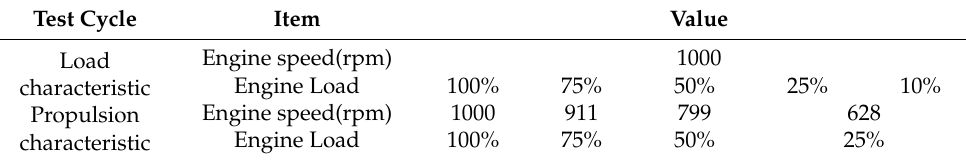
Table 5. Test cycle for different test points.